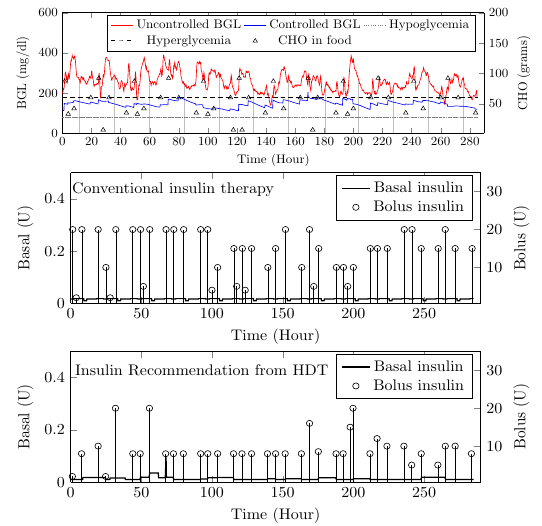
Figure 26. Insulin recommendation and BGL for P 13 —Comparison between uncontrolled clinical trial and controlled BGL excursions with HDT framework is shown in the top plot. The middle plot shows the insulin recommendation during the clinical trial. The bottom plot shows insulin recommendations from